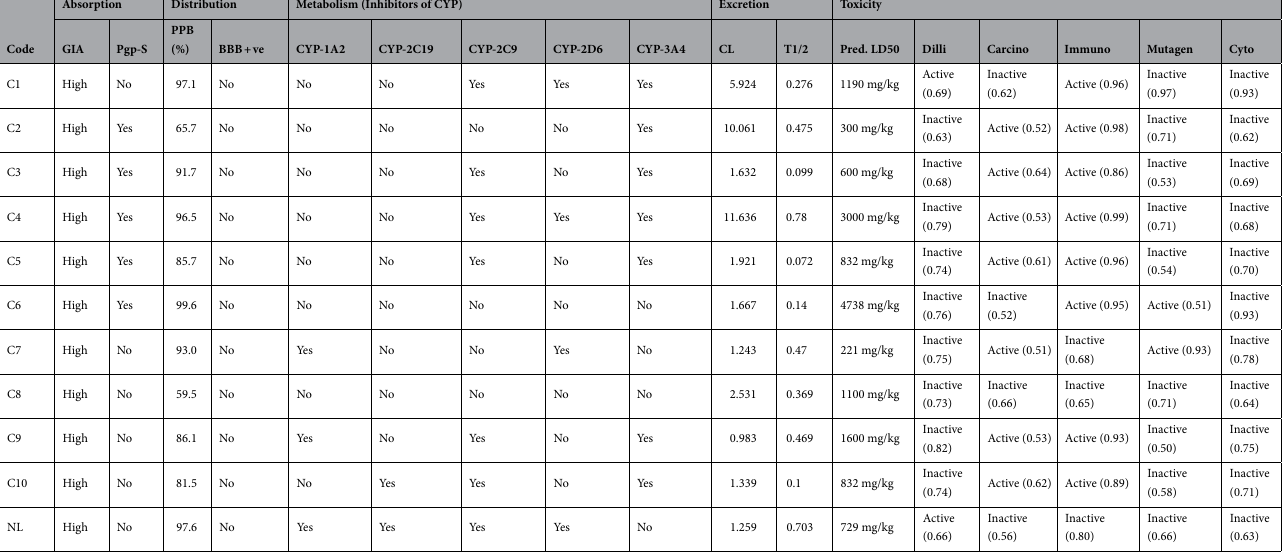
Table 3. ADME-T profile of top 10 best